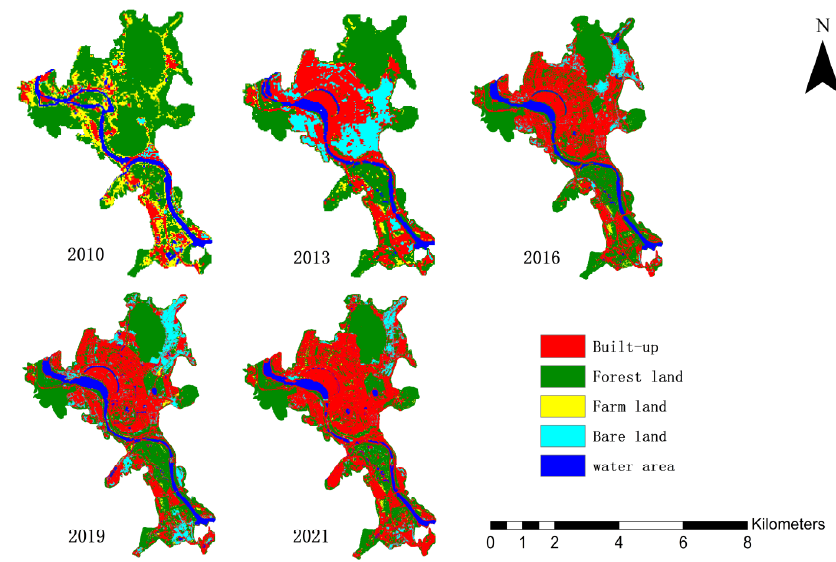
Table 5. Land-use area transfer matrix 2010–2021 (percent).